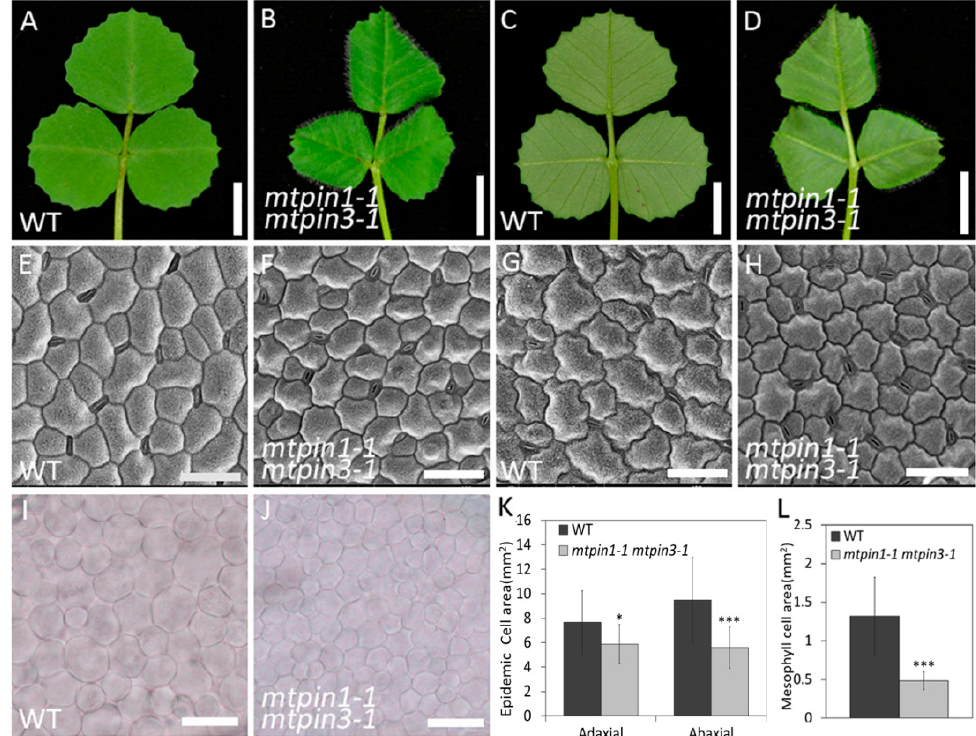
Figure 3. Defects in leaf development in mtpin1-1 mtpin3-1 double mutant. ( A , B ) the adaxial side of a fully expanded leaf in 45-day-old wild-type and mtpin1-1 mtpin3-1 at the vegetative stage. ( C , D ) the abaxial side of a leaf in wild-type and mtpin1-1 mtpin3-1 . ( E – H ) scanning electron microscope (SEM) images of epidermal cells of the adaxial (E and F) and abaxial ( G , H ) sides of a fully expanded leaf from 45-day-old wild-type (WT) and mtpin1-1 mtpin3-1 . ( I , J ) Phase contrast microscopy images of mesophyll cells of wild-type and mtpin1-1 mtpin3-1 . ( K ) Measurement of epidemic cell area of